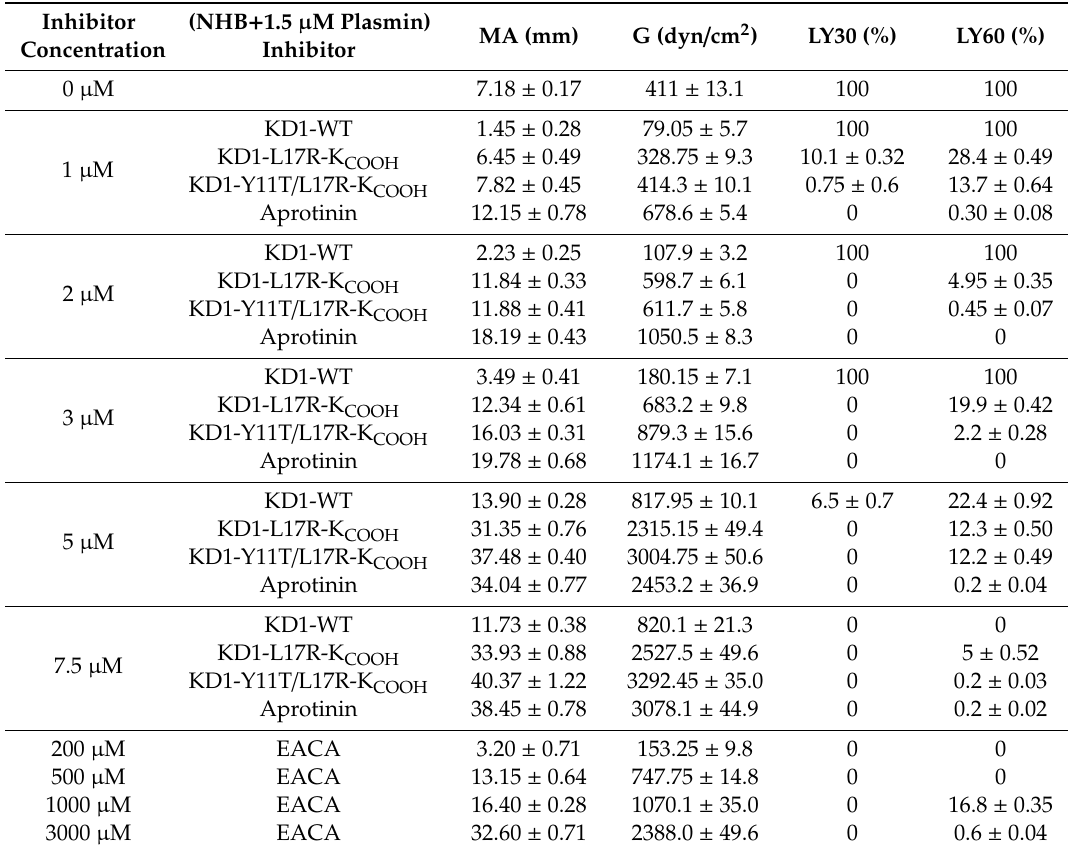
Table 3. E ff ect of KD1-WT, KD1-L17R-K COOH , KD1-Y11T / L17R-K COOH , aprotinin and EACA on the TEG